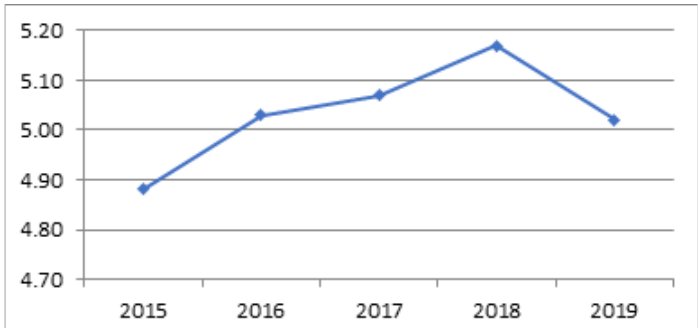
Figure 2: The Economic Growth in Indonesia (Percent), 2015-2019 Source: BPS